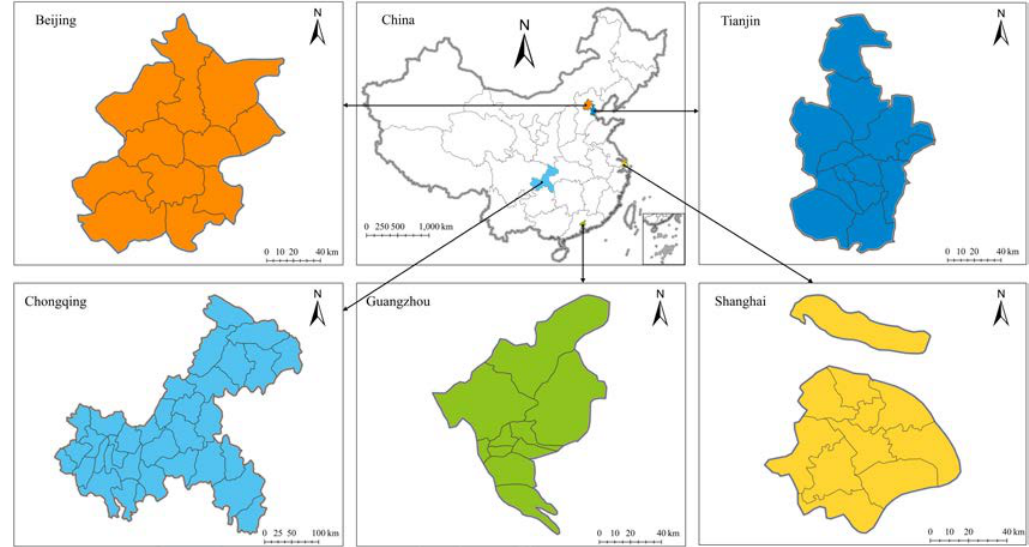
Figure 1. Locations of the five Chinese megacities in this study: Beijing and Tianjin in North China, Shanghai in East China, Chongqing in West China, and Guangzhou in South China.